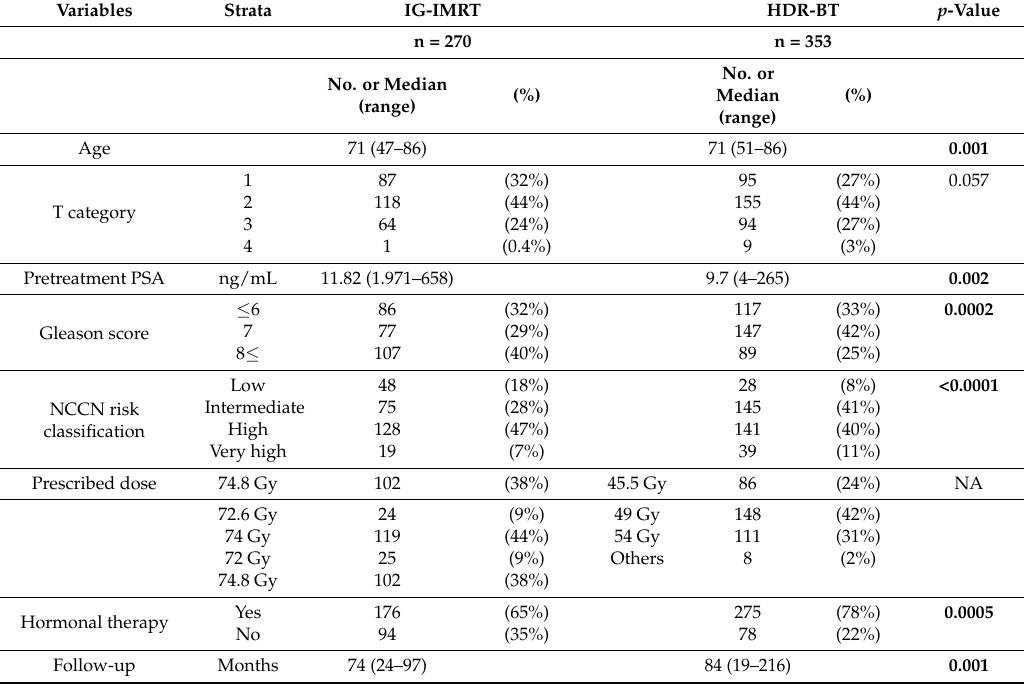
Table 1. Characteristics and treatment factors of